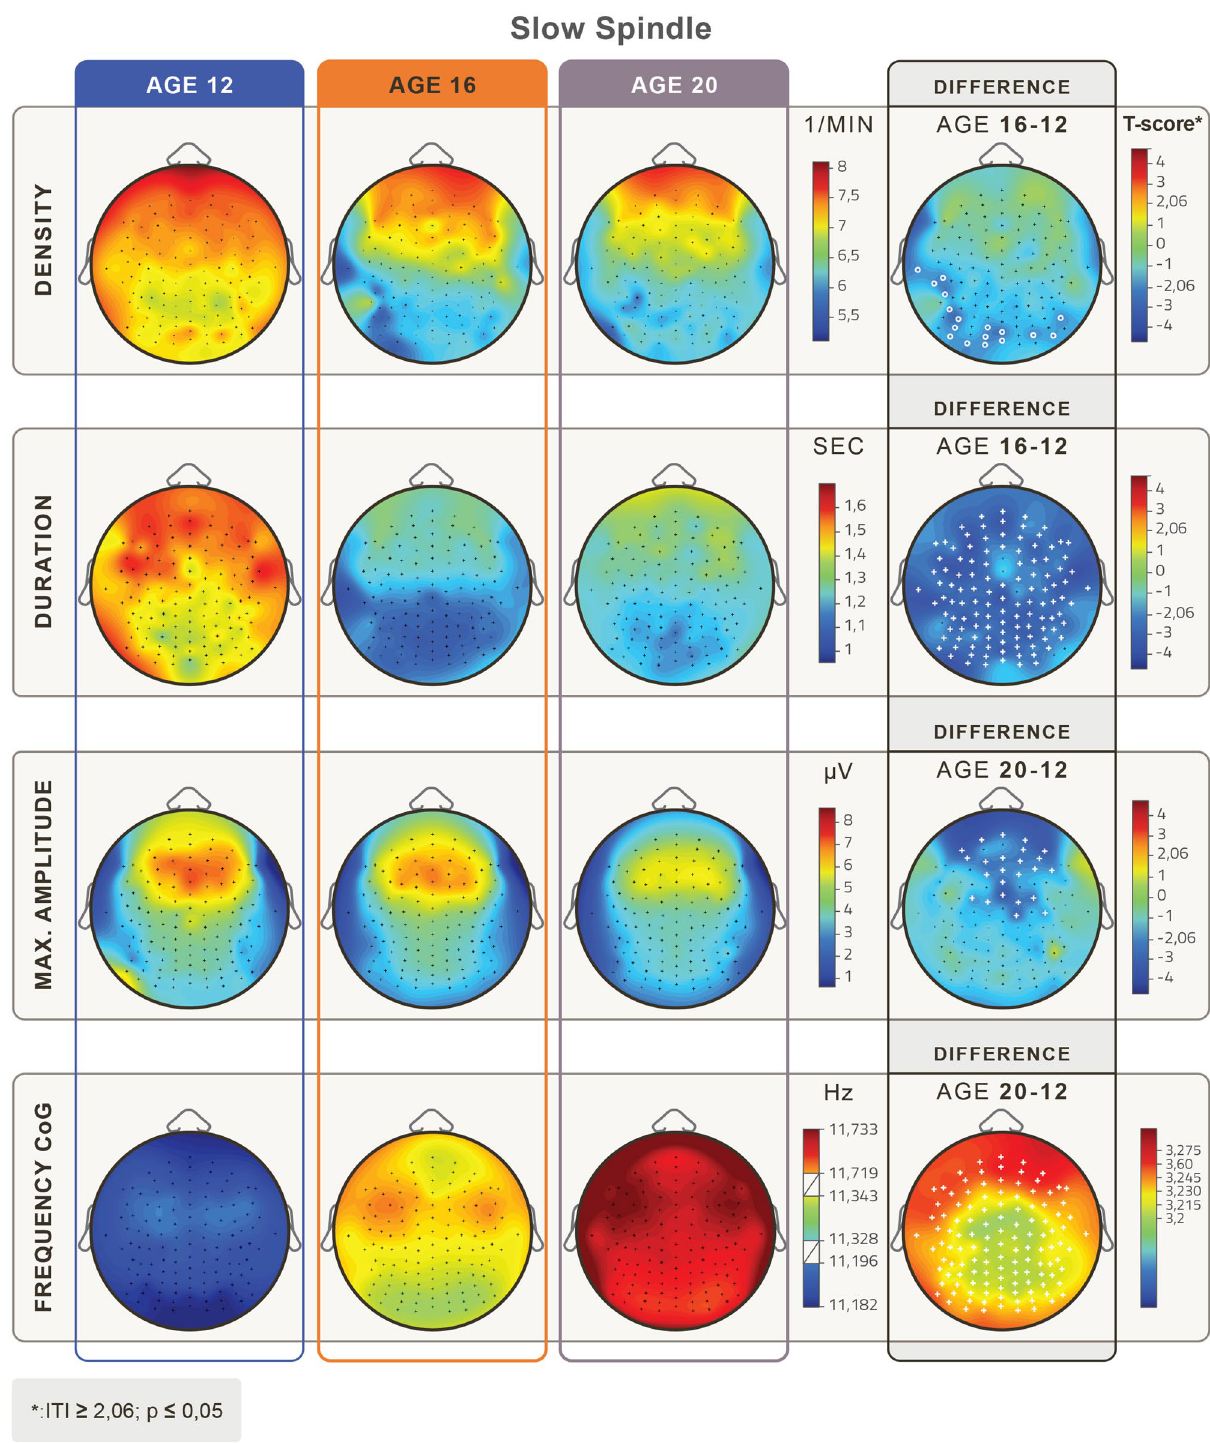
Figure 1. Topographical distribution of mean slow sleep spindle parameters in the age groups of 12, 16 and 20 years of age. Rows depict age-related changes in slow sleep spindle density (1/min), duration (s), maximum amplitude (µV), and frequency based on the center of gravity (CoG) (Hz). Relevant age-group differences are depicted in the 4th column. White crosses depict Rüger area significant differences and white circles depict significant but not Rüger area significant differences. Age-related decreases in density are significant with an occipital and left temporal focus. There was a significant overall decrease in duration and a frontal-frontopolar decrease in maximum amplitude. Frequency increases at all derivations with a frontal focus from the younger to the older age groups. (Level of significance: p < .05, T-score values are matched with the colorbar, T ≥ │ 2.06 │ p < 0.05, at T ≥ │ 2.787 │ p < 0.01 and at T ≥ │ 3.725 │ p <